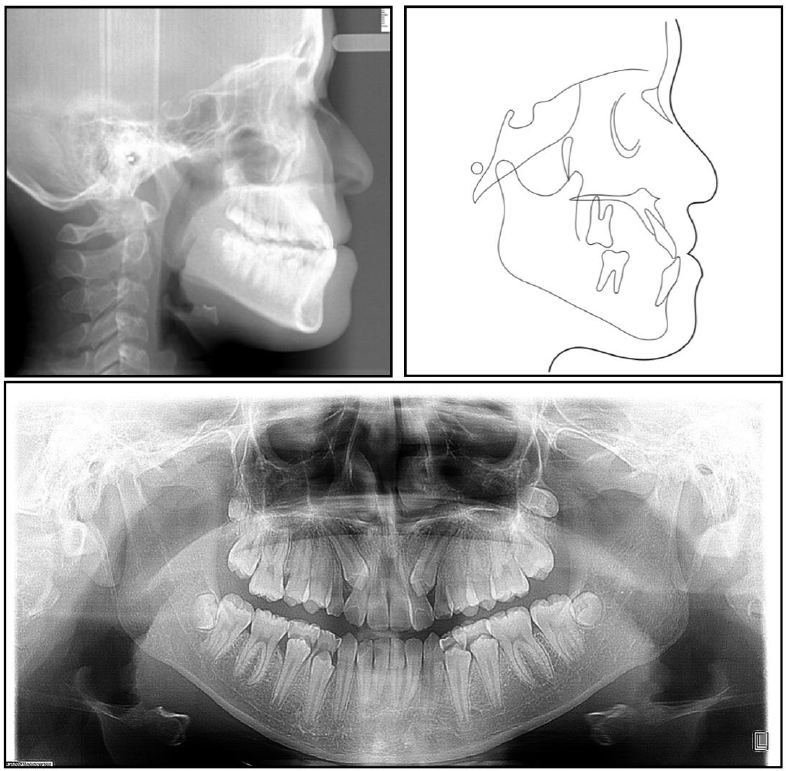
Figure 3. A pretreatment lateral cephalometric radiograph and tracing and a panoramic